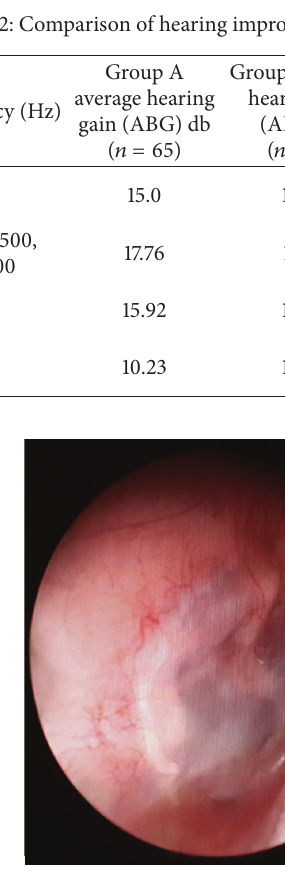
Figure 3: Postoperative picture at 6 months after temporalis fascia tympanoplasty.